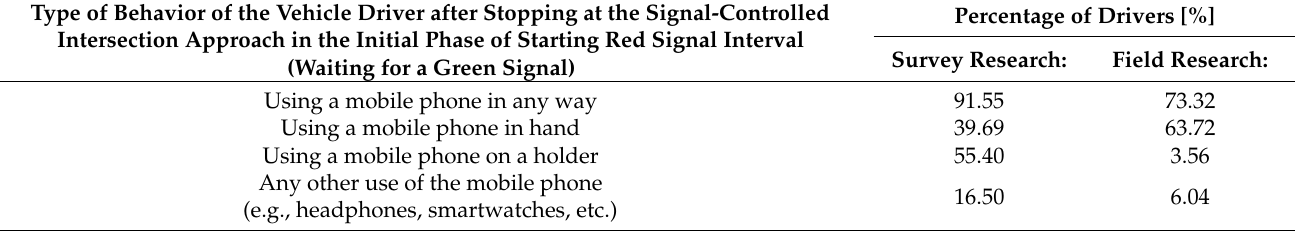
Table 1. Comparison of the results of questionnaire and empirical research in the case of using a mobile phone.